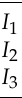
Table 5. The spacecraft principal moment of inertia components (kg · m 2